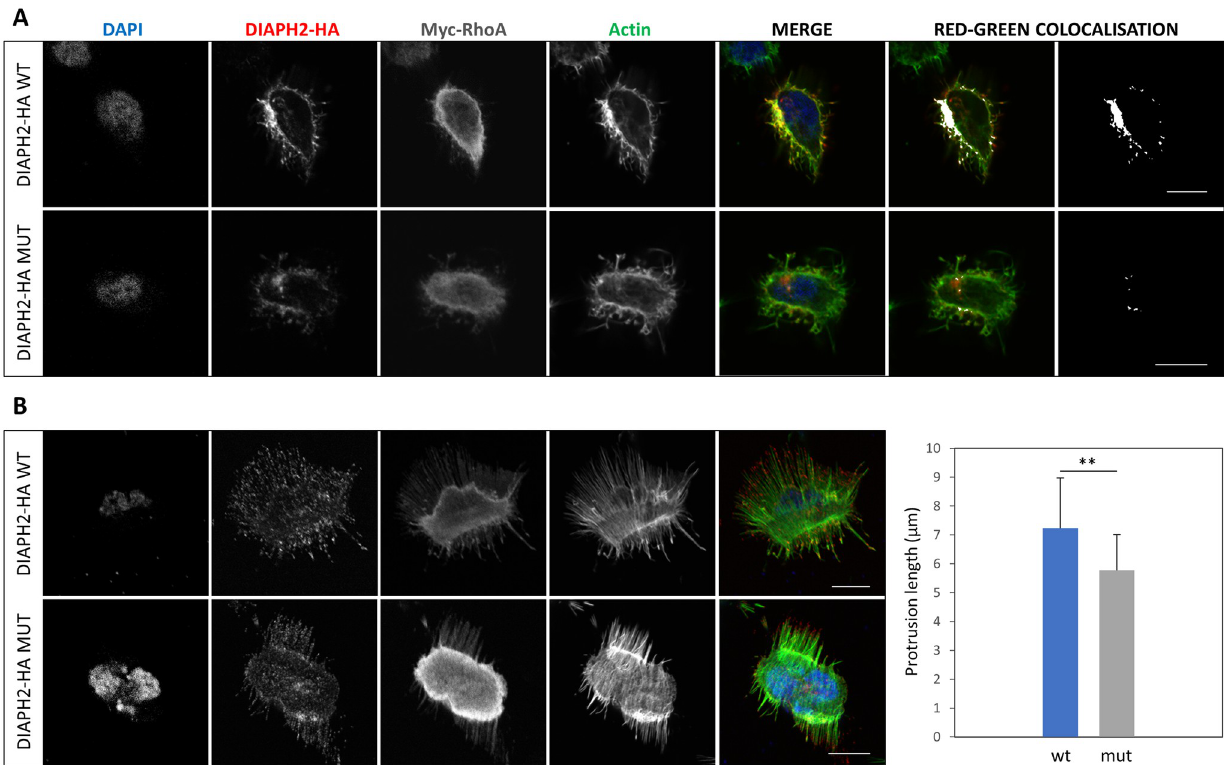
Fig 5. Evaluation of DIAPH2 localization and of the length of membrane protrusions in HEK293 under activating stimuli. DIAPH2 localization and cell morphology was evaluated in HEK293 cells 48 hours after transfection with plasmids coding for HA-tagged isoforms of wild-type or mutant DIAPH2 (DIAPH2-HA WT, DIAPH2-HA MUT), together with a Myc-tagged active form of RhoA (Myc-RhoA). ( A ) Single middle confocal sections for each channel and the merged image of the blue, red and green channels are shown. Image of colocalized pixels (in white, as generated by Fiji colocalization plugin) superimposed or not on a RG-merge are shown. ( B ) Single confocal sections of cells at the level of their adhesion to the glass are shown. The merged image of the blue, red and green channels is also shown. On the right, histograms representing the mean length of protrusions measured using Fiji in 20 wt and 20 mut HEK293 cells, with error bars showing the standard deviations. Significance level of unpaired t-test is shown ( �� : p < 0.01). Images were acquired with Leica True Confocal Scanner (TCS) SP8 and are representative of 3 experiments. Scale bar: 10 μ